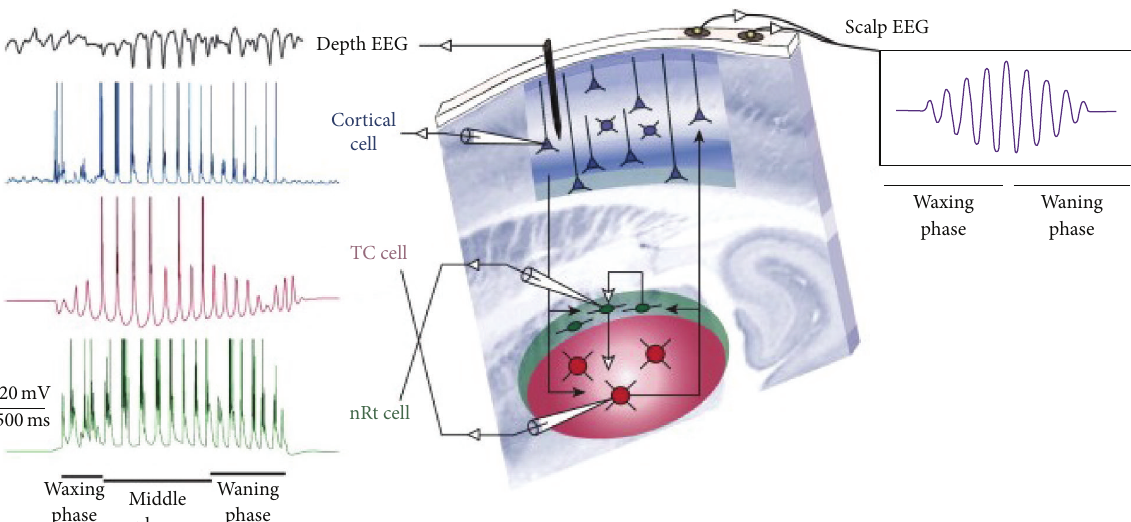
Figure 2: Spindles are generated in thalamocortical (TC) loop. The reticular (nRt) cells encounter the TC cells confined within the thalamus. The nRt cells inhibit TC cells which project excitatory inputs to the cortical cells. Cortical cells send excitatory input back to thalamic neurons. Sleep spindles arise from a cascade of recurrent, inhibitory, and excitatory signals between nRt, TC, and cortical cells. Modified from